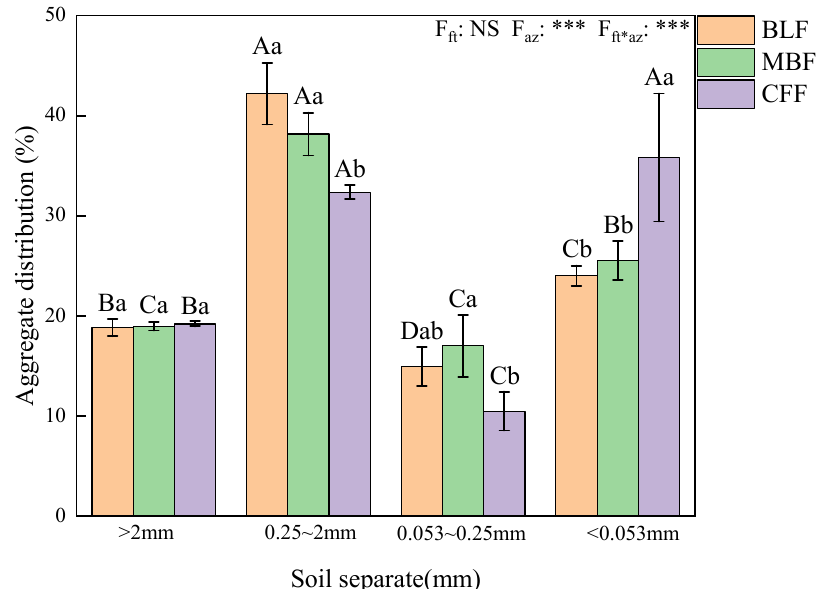
Figure 2. The comparison of the number of soil aggregates in different forest types of the same fraction and different fractions of the same forest type. Bars with different letters are significantly different ( p < 0.05). Small letters indicate difference of soil aggregate proportion in three forest types with the same fraction. Large letters indicate difference of soil aggregate proportion in different fractions in the same forest types. F ft represents forest type, F af represents aggregate fraction, NS indicates no significant difference, *: p < 0.05, ***: p < 0.001.